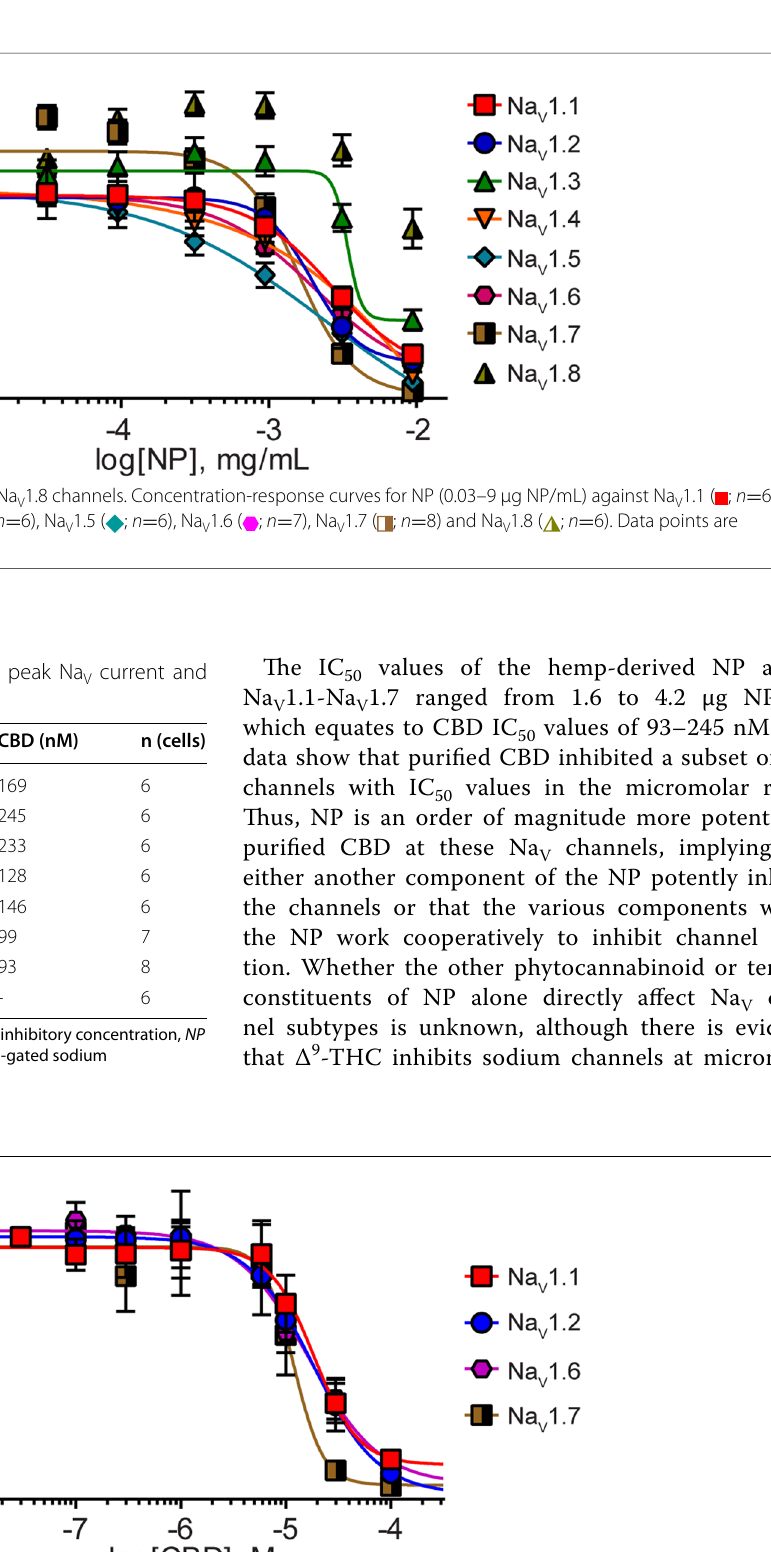
Fig. 5 Variable potency of purified CBD for a subset of the Na V channels. Concentration-response curves for purified CBD (0.1–100 μM) against Na V 1.1 ( ; n 9), Na V 1.2 ( ; n 6), Na V 1.6 ( ; n 7) and Na V 1.7 ( ; n 7). Data points are mean = = = =